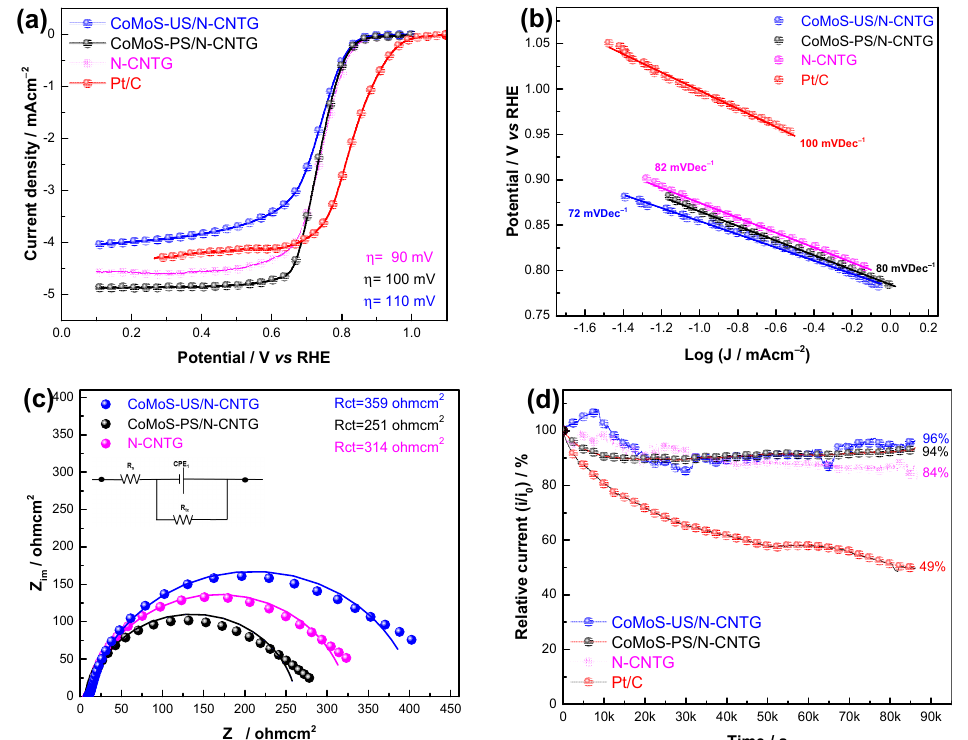
Figure 5. ( a ) Comparative LSV at 1600 rpm for the evaluated materials; ( b ) Tafel plots obtained by the corresponding LSV curves; ( c ) Nyquist plots for the synthesized materials; and ( d ) ORR stability curves under O 2 -saturated 0.1 M KOH solution.